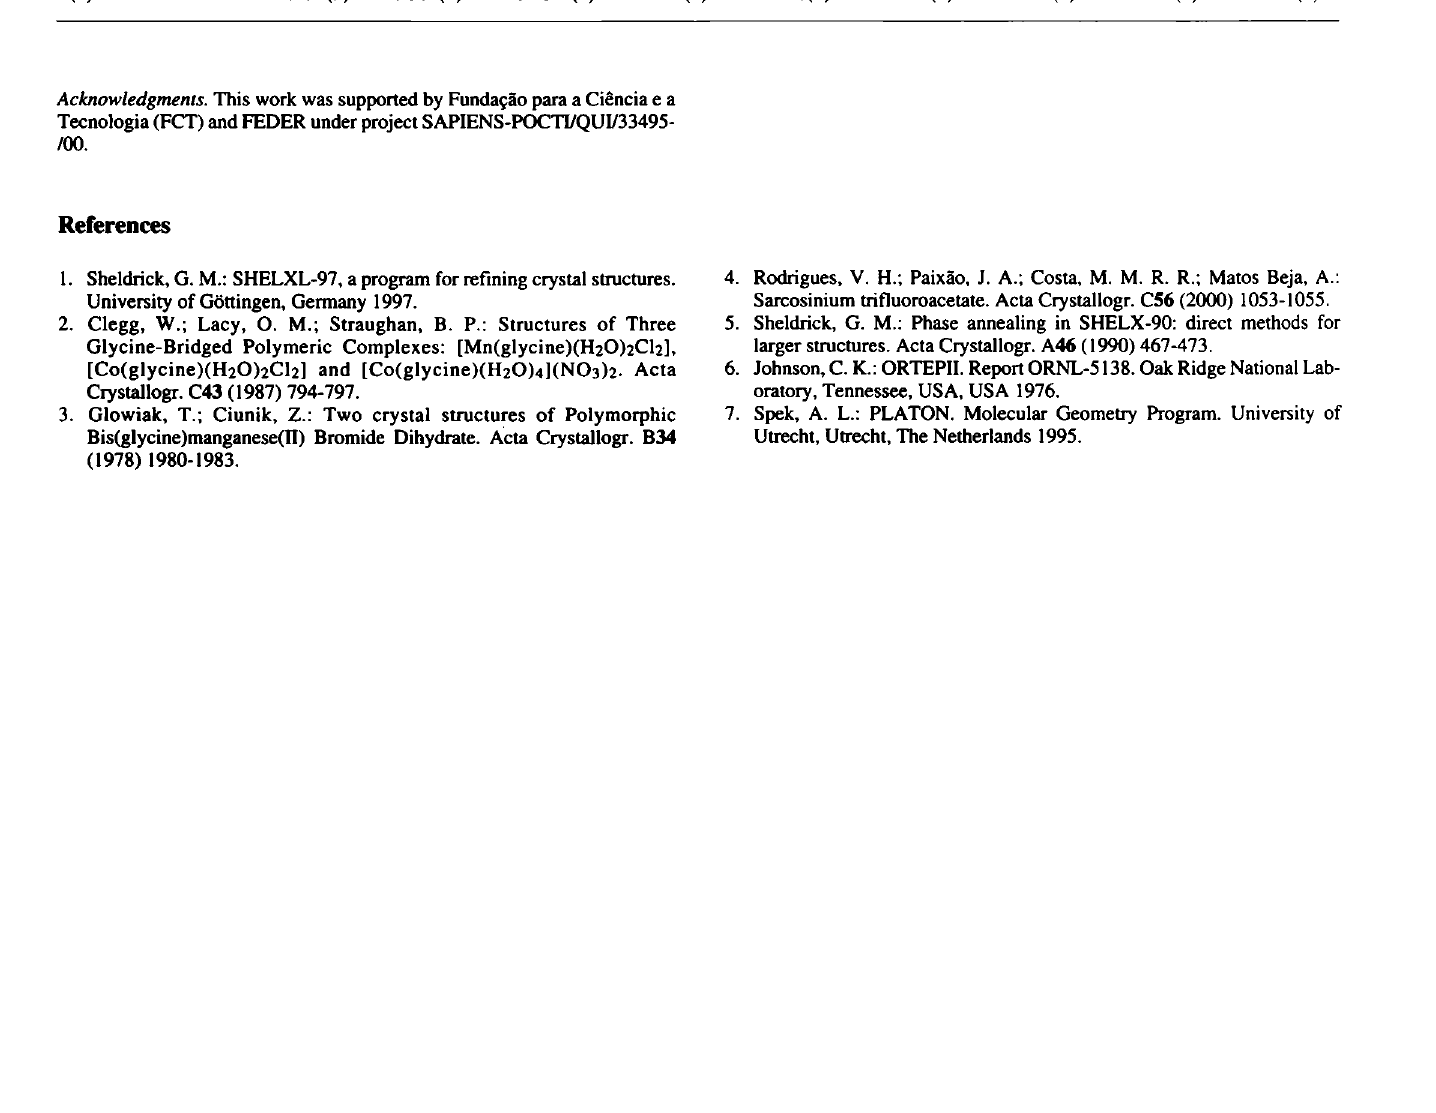
Table 3. Atomic coordinates and displacement parameters (in Ä 2